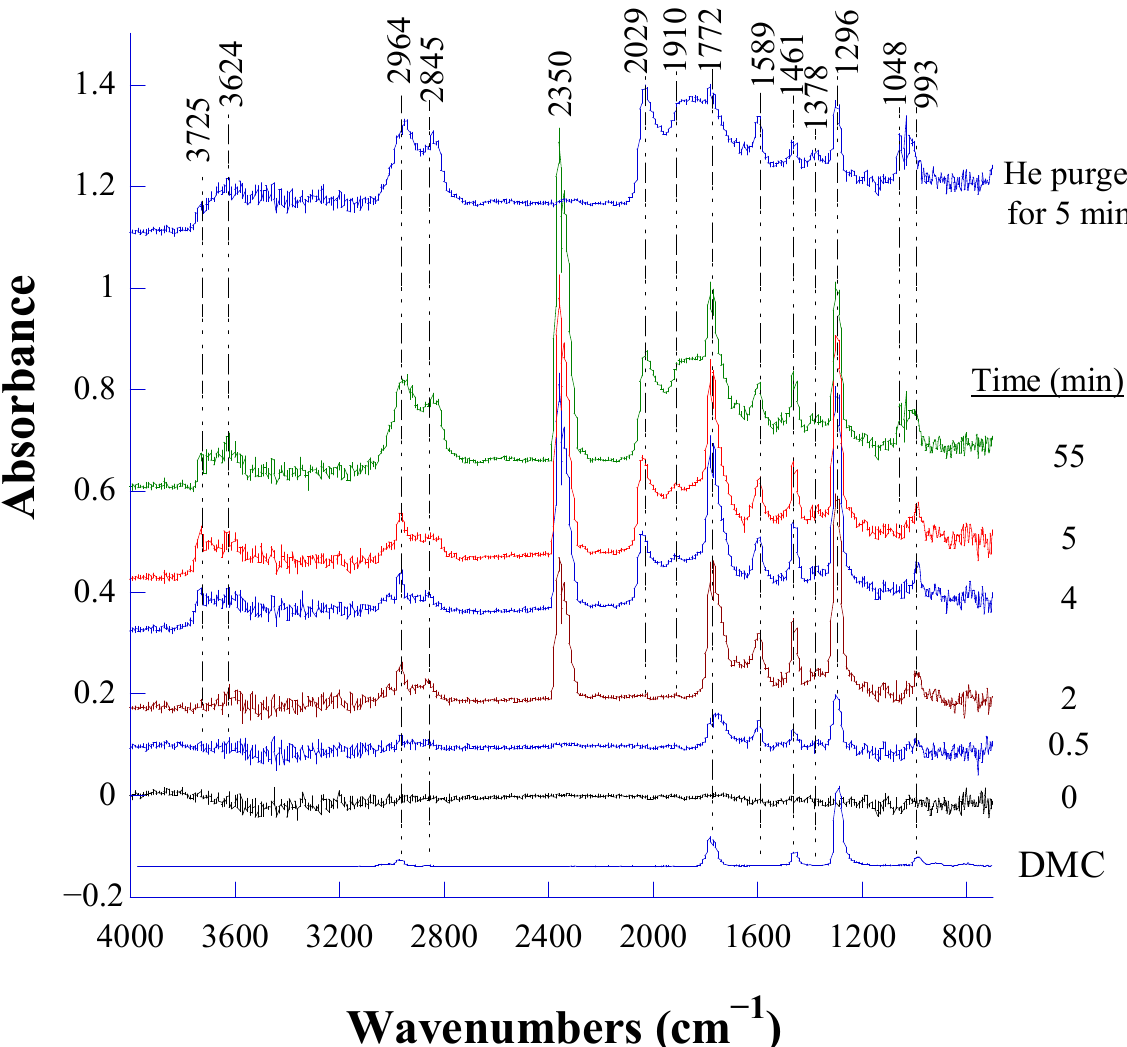
Figure 4. IR spectra during exposure of 5% Rh/Al 2 O 3 to DMC flow at 373 Figure 4- IR spectra during exposure of 5% Rh/Al 2 O 3 to DMC flow at 373 K. The dynamics of IR spectra of reaction ingredients during the flow of methanol/CO 2 over Rh/Al 2 O 3 catalyst at 373 K are shown in Figure 5. The initial IR spectrum at 0.5 min produces bands at 1589 and 1461 cm − 1 . After 5 min of exposure to methanol/CO 2 , the in- tensity of the C–H stretching bands at 2964 and 2845 cm − 1 increased, together with the intensities of linear and bridge CO at 2029 and 1873 cm − 1 , respectively. At the same time, weak bands appeared at 1772 cm − 1 , which can be assigned to gaseous DMC. The observed dynamics of IR spectrum are probably due to the change of state of Rh, particularly re- duction of Rh.